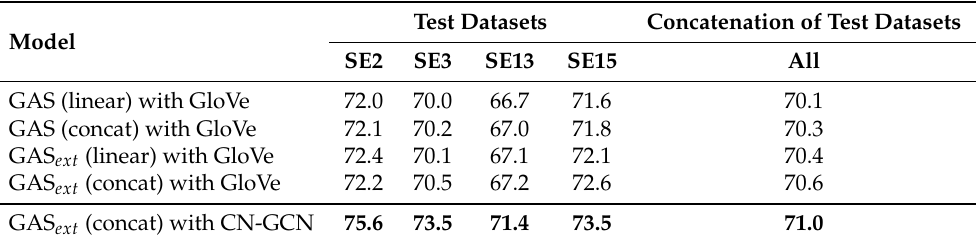
Table 3. F1-score on fine-grained English all-word word sense disambiguation (WSD). Bold indicates high performance. The SE7 task was considered for all performances.